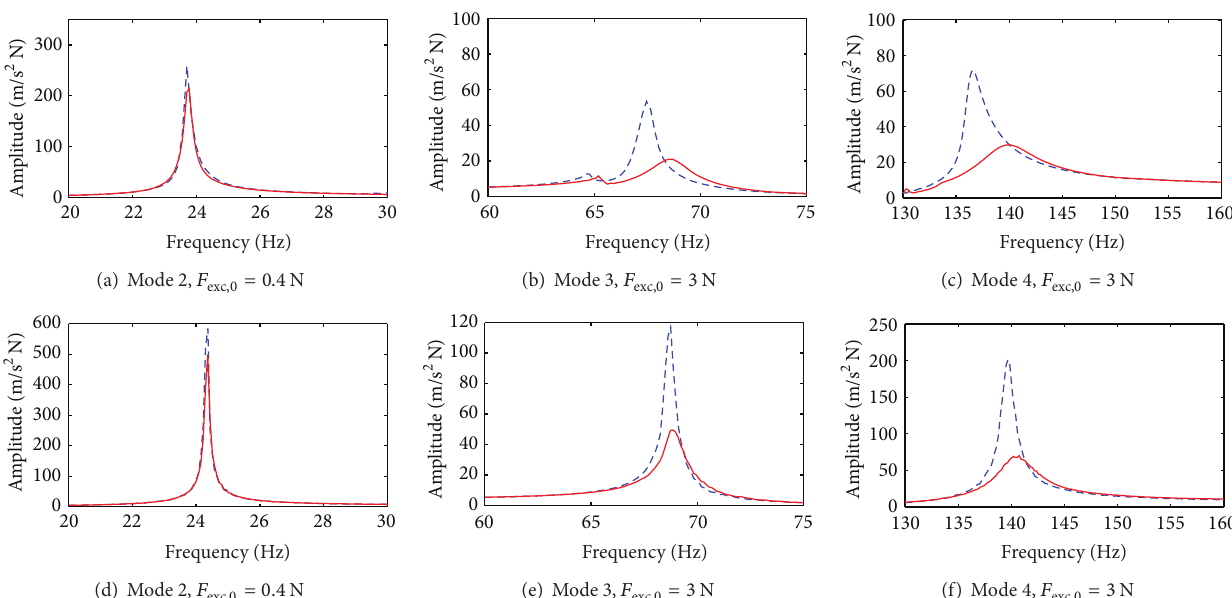
Figure 7: Hysteresis-optimal control: measured (top) and simulated (bottom) accelerance FRFs for controlled sine-sweep excitation with (solid) and without (dashed) control (𝑘 ∗ 𝑇 = 2.5 ⋅ 10 7 N / m )